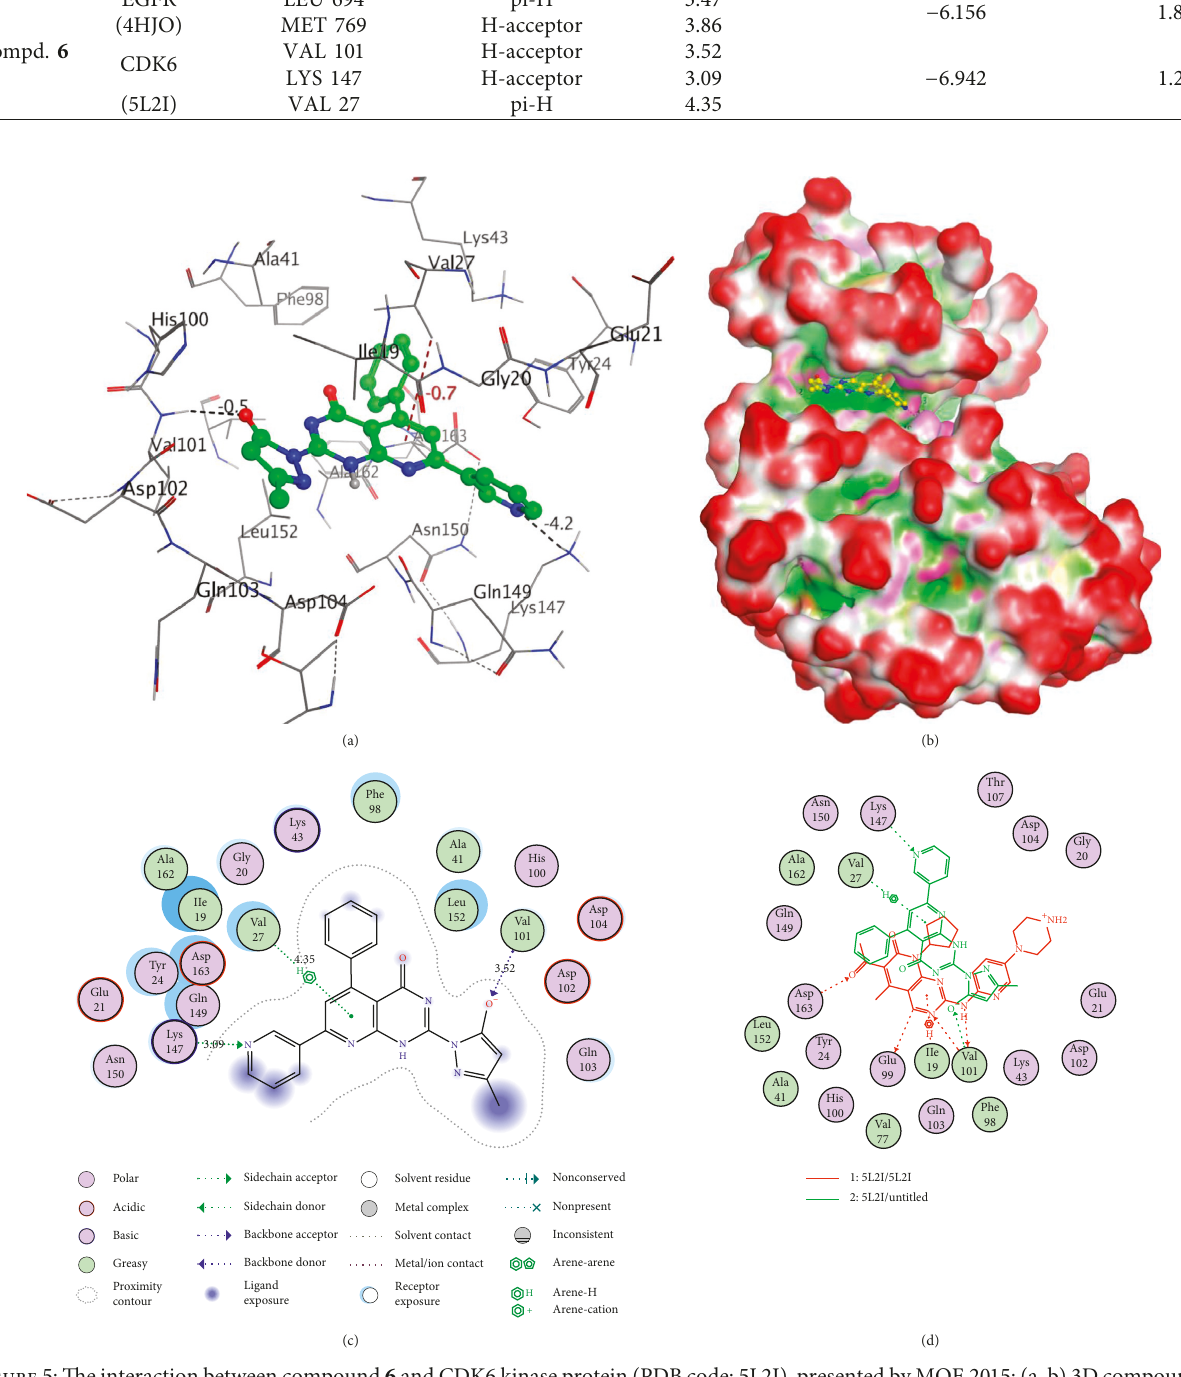
Figure 5: The interaction between compound 6 and CDK6 kinase protein (PDB code: 5L2I), presented by MOE 2015: (a, b) 3D compound 6 binding geometry (yellow sticks) in the CDK6 binding site cavity. (c) 2D interaction diagram of compound 6 with the CDK6 binding site cavity. (d) 2D diagrams of compound 6 (green) and padlbocyclib (red) were